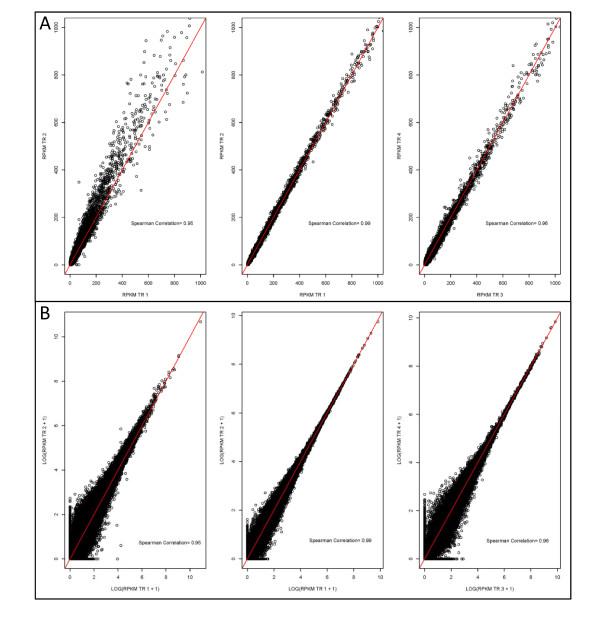
Scatterplot of technical replicates. Points where RPKM is 1000 or less are displayed (A). The red line is the 45 degree line. Left panel is D. simulans male heads BR2, middle panel is D. melanogaster female heads BR2 and right panel is D. melanogaster cell line c167 Tr3 vs TR4. Spearman correlation values are (0.95, 0.99, 0.96), respectively. Scatterplot of technical replicates on the log scale (log(RPKM+1)) for RPKM values of less than 1000) (B). The red line is the 45 degree line. Left panel is D. simulans male heads BR2, middle panel is D. melanogaster female heads BR2 and right panel is D. melanogaster cell line c167 Tr3 vs TR4. Spearman correlation values are (0.95, 0.99, 0.96), respectively.